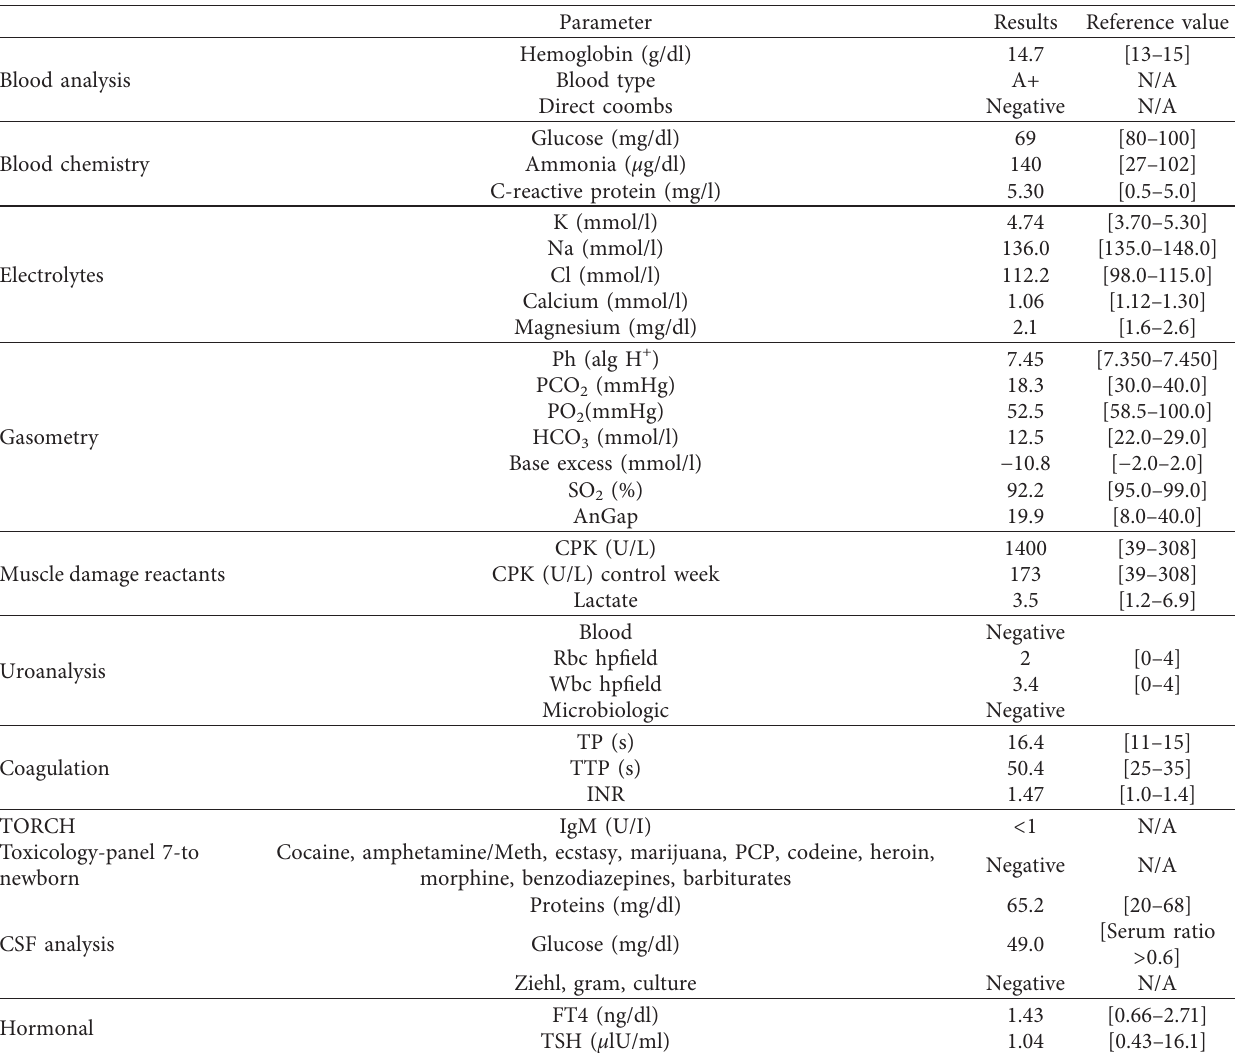
Table 1: Laboratory results from the